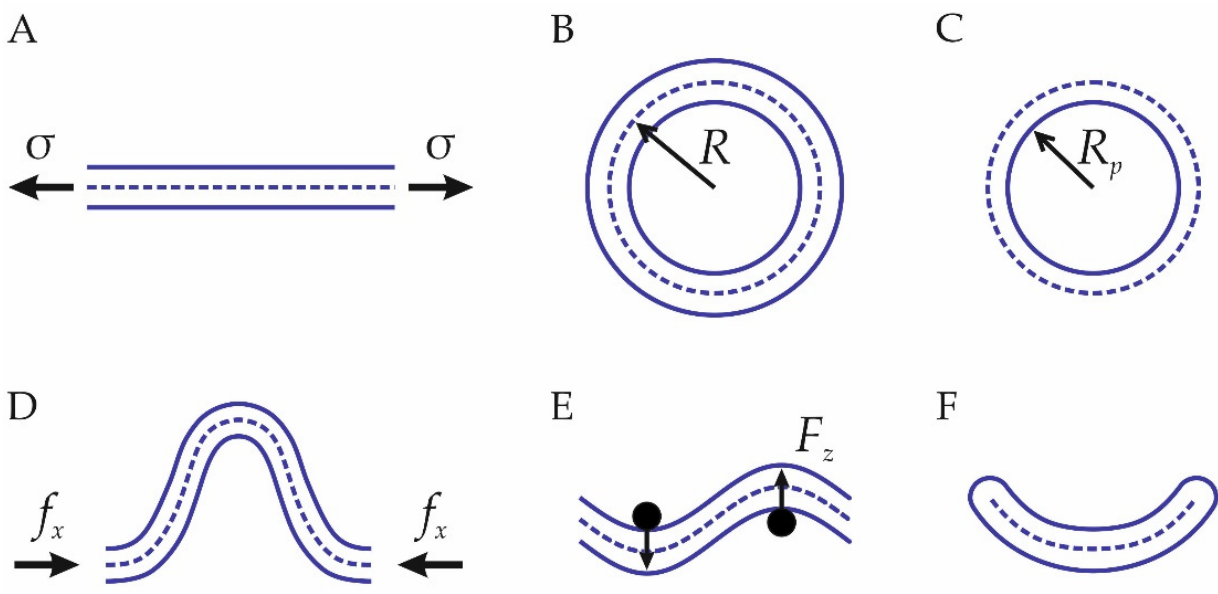
Figure 3. Major configurations of lipid membranes, considered in Section 3. Solid and dashed curves represent the shapes of lipid monolayers and midsurfaces, respectively. ( A ) Planar configuration of a lipid bilayer, subjected to the lateral tension σ . ( B ) Cross section of a bilayer nanotube of radius R . ( C ) Cross section of a cylindrical micelle, an individual cell of the H II phase; R p is the distance from the pivotal surface to the cylinder center. The dashed circle represents the boundary of the hydrophobic region of lipid tails. ( D ) Membrane buckle due to a large lateral compression with force f x . ( E ) Sinusoidal configuration, generated by two parallel cylinders (black circles), each of which pushes the membrane with the force of magnitude F z . ( F ) Unbending configuration of a half-cylinder.